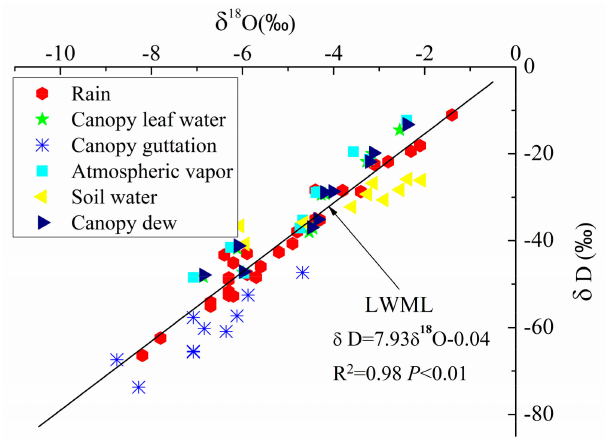
Figure 3. Stable isotopes of water by type and the local meteoric water line (LMWL) in